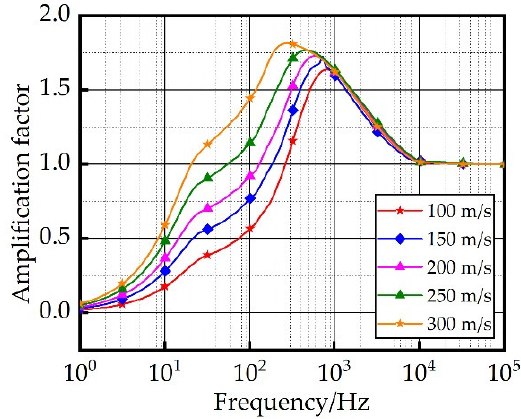
Figure 21. Acceleration shock response spectrum of vehicle without buffer at different speeds of water entry.